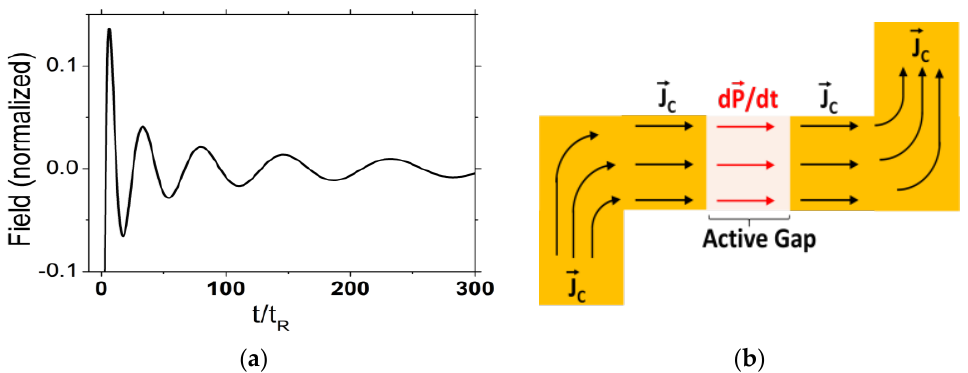
Figure 8. ( a ) Analytic solution to sine-Gordon equation the characteristic “ringing” of superradiance. ( b ) The polarization current and coupling to THz antenna.